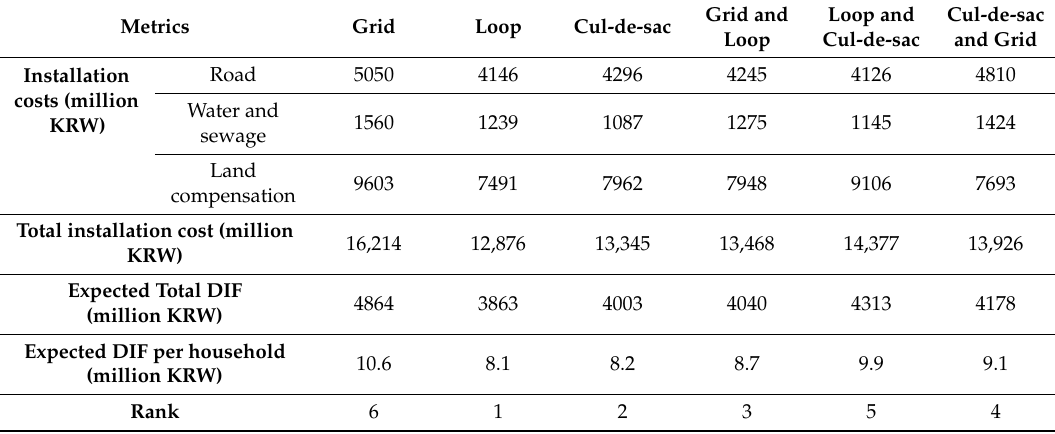
Table 4. Calculation of installation costs and expected development impact fee (DIF) for each